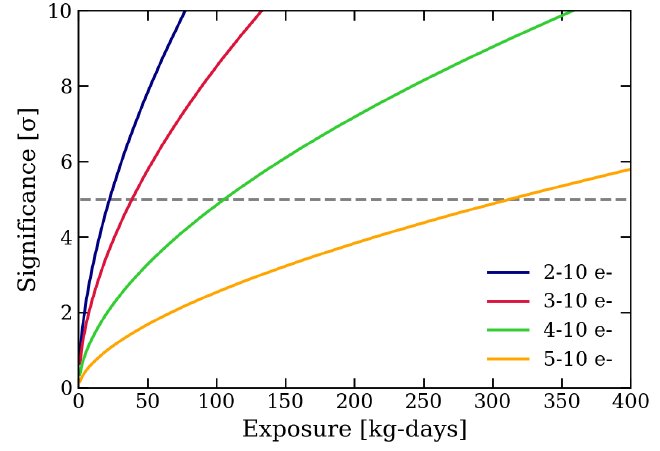
Figure 2. Significance to detect neutrino CE ν NS as a function of exposure using a liquid xenon detector placed about 25 m away near the core of a 3 GW thermal power reactor, assuming differ- ent achievable detector thresholds and a single-and-few electrons background comparable to that measured in